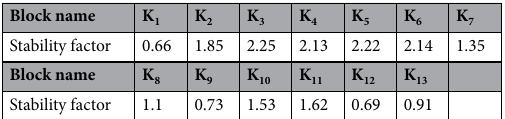
Table 6. Stability coefficient of each block.